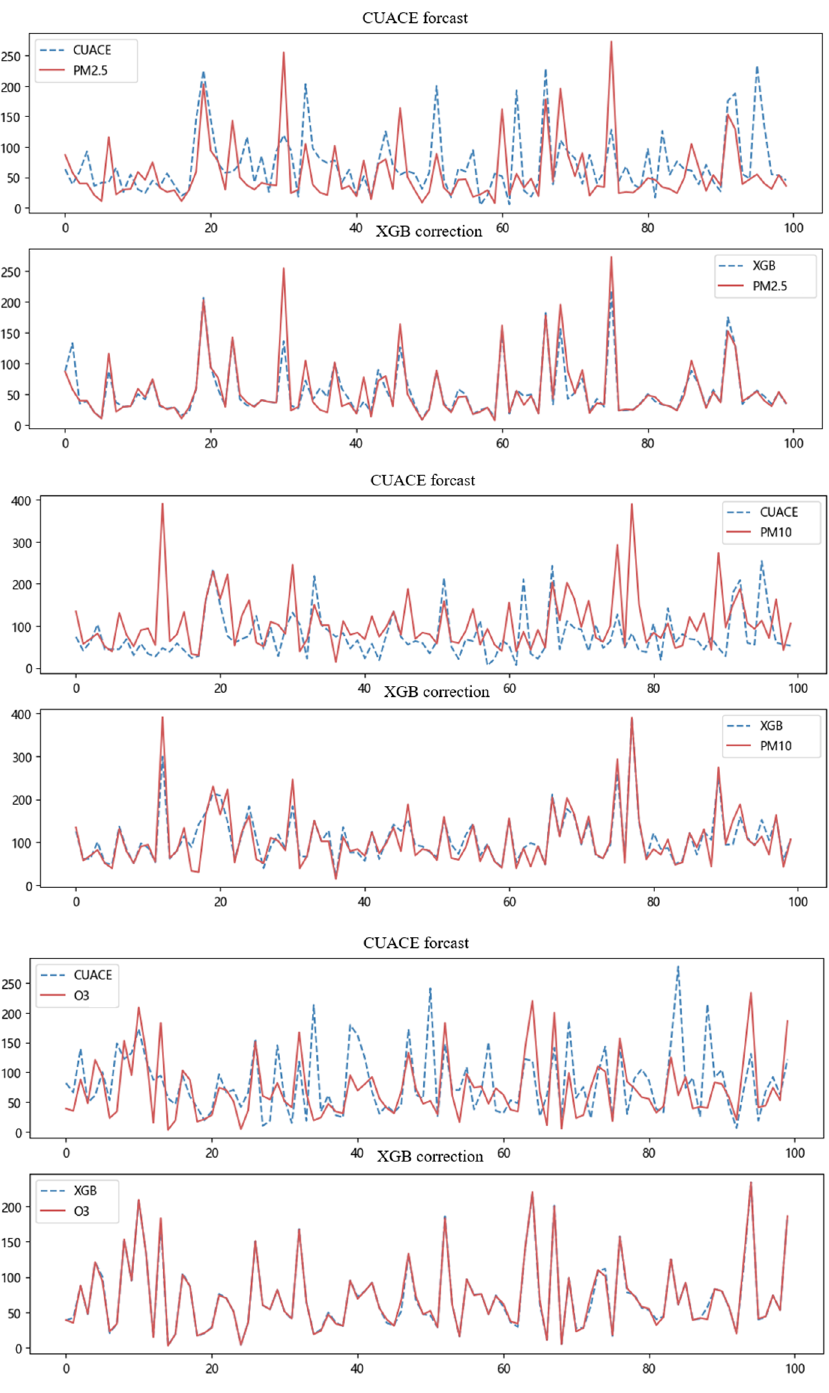
Figure 8. XGB algorithm correction results.